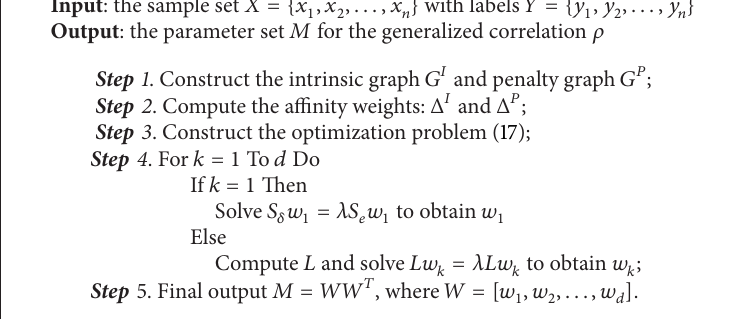
Algorithm 1: The details of algorithm